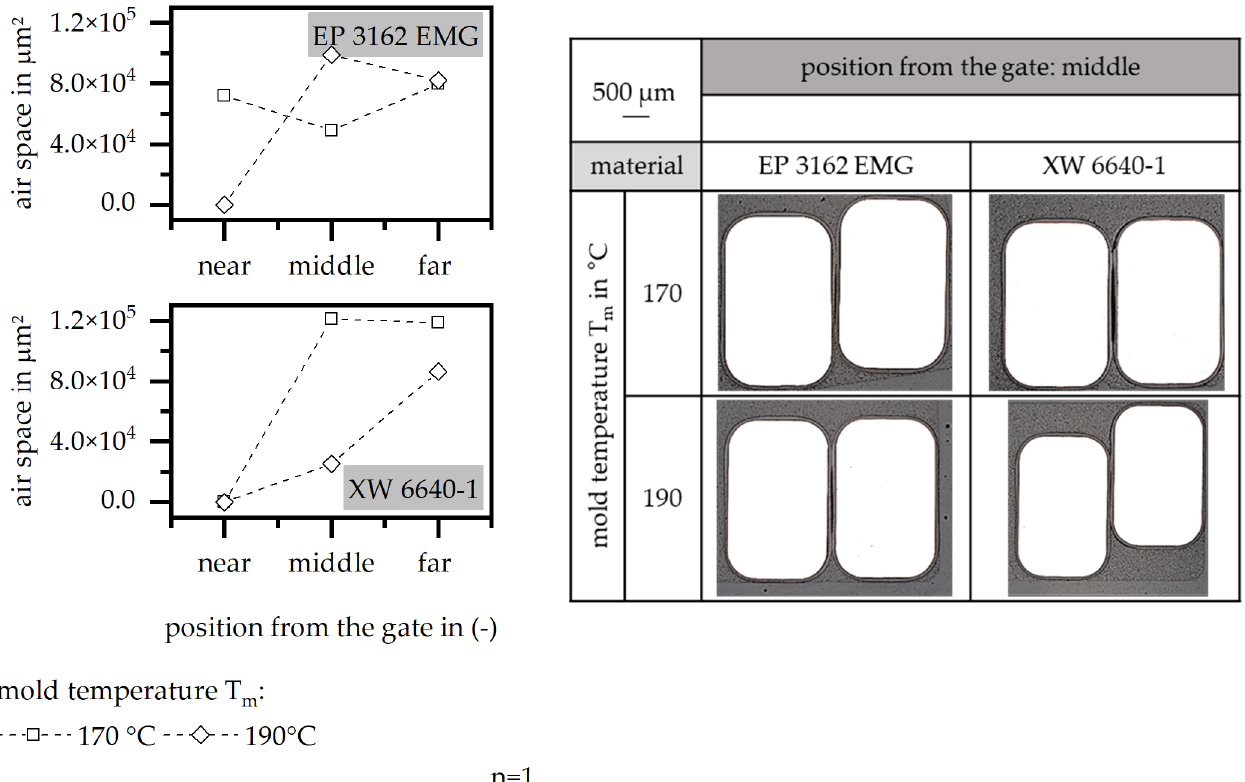
Figure 11. Airspace and position of the wire relative to the stack, relative to the mold temperature in the insulation system.